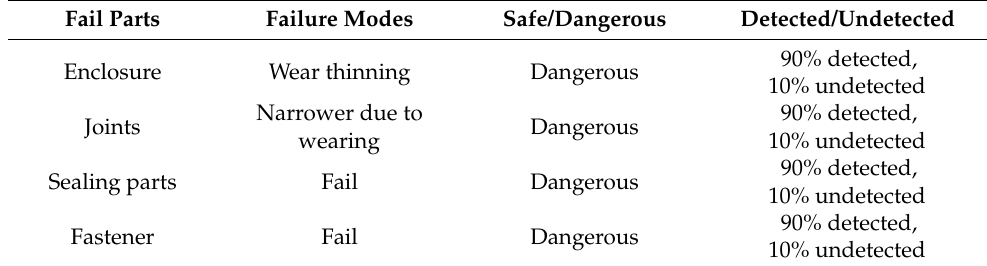
Table 2. Failure mode of flame-proof